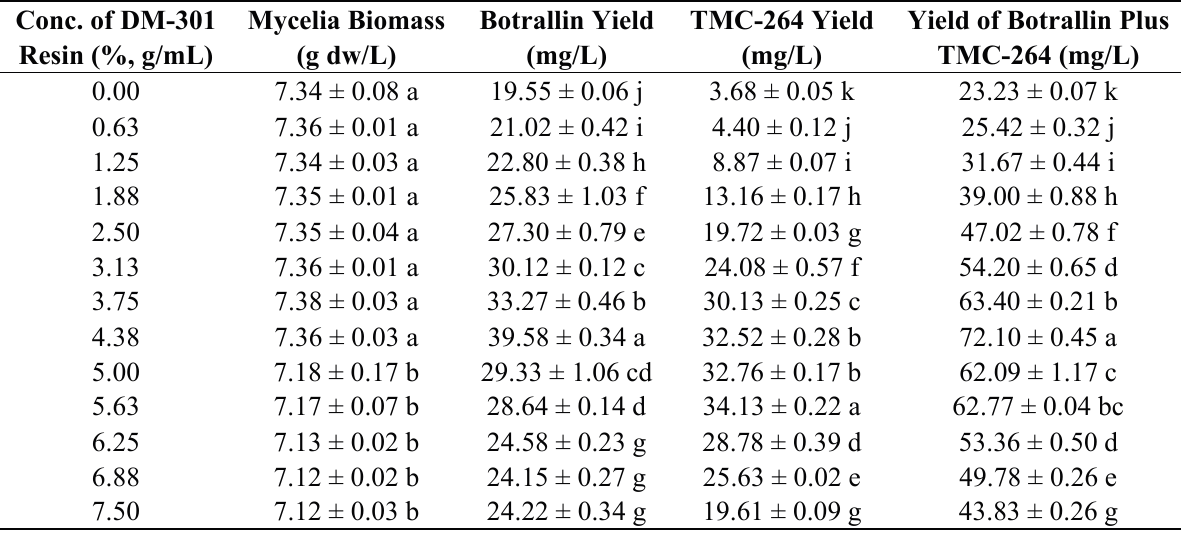
Table 2. Effects of the DM-301 resin on mycelial growth, production of botrallin and TMC-264 in liquid culture of Hyalodendriella sp. Ponipodef12. Conc. of DM-301